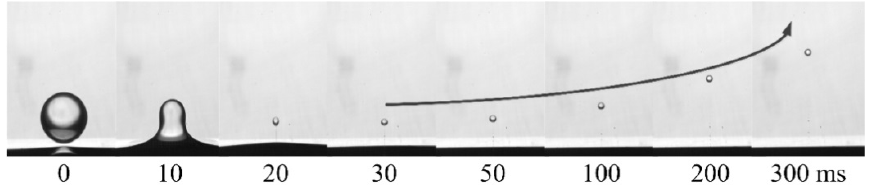
Figure 14. Rising process of secondary droplet in a DC electric field.